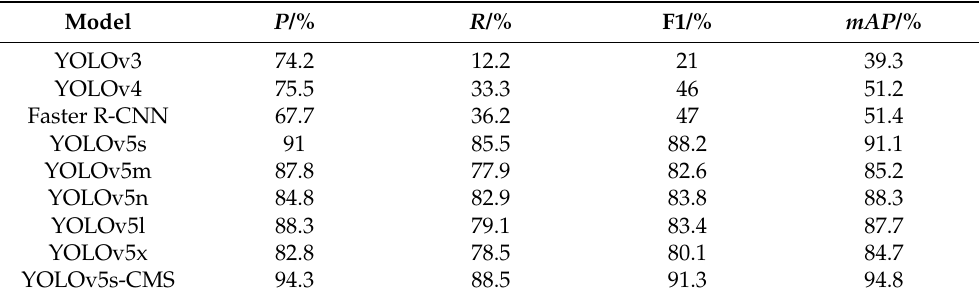
Table 4. Comparison between different target detection